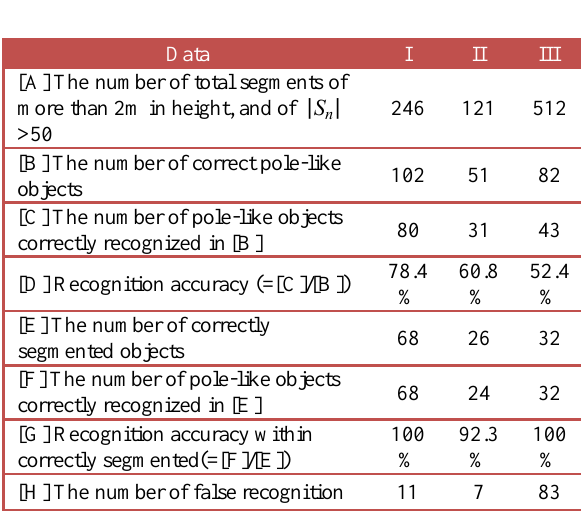
Figure 9. Result of the pole-like object recognition